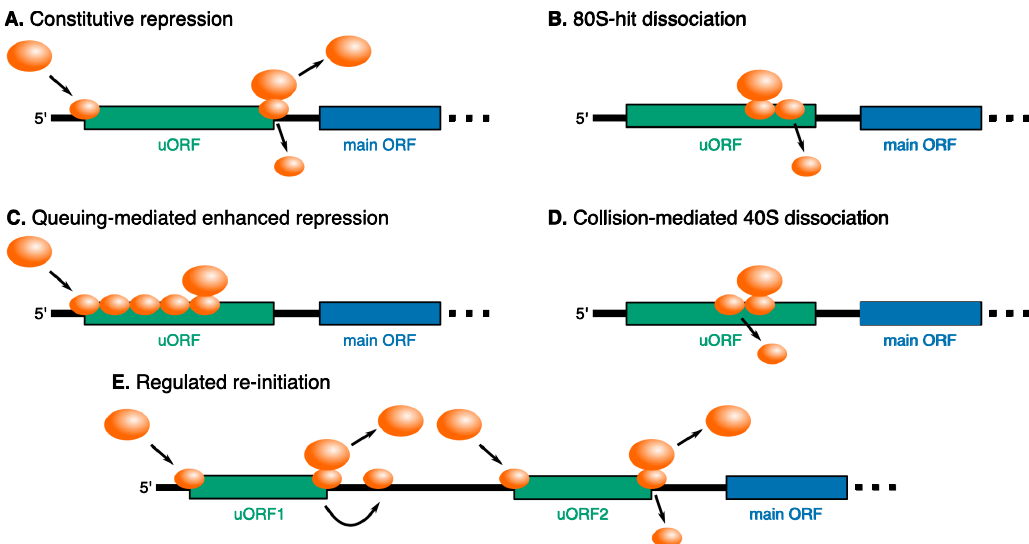
Fig 1. Models of uORF regulation considered in this study. (A) Constitutive repression . The uORF constitutively siphons away a proportion of scanning ribosomes from the main ORF. (B) 80S-hit dissociation . Elongating ribosomes that collide with 3 0 scanning ribosomes cause the leading scanning ribosome to dissociate from the mRNA. (C) Queuing-mediated enhanced repression . Scanning or elongating ribosomes form a queue behind a 3 0 stalled elongating ribosome. If the queue correctly positions a scanning ribosome at the uORF start codon, then the proportion of scanning ribosomes that initiate translation at the uORF start codon increases. (D) Collision-mediated 40S dissociation . Scanning ribosomes that collide with a 3 0 stalled ribosome dissociate from the mRNA. (E) Regulated re-initiation . Ribosomes initiate translation at the first uORF start codon, and scanning continues after termination at the stop codon of the first uORF. Ribosomes re-initiate at the main ORF start codon or the second downstream uORF start codon when phosphorylated eIF2 α levels are high or low, respectively. The schematic is depicted in a low phosphorylated eIF2 α